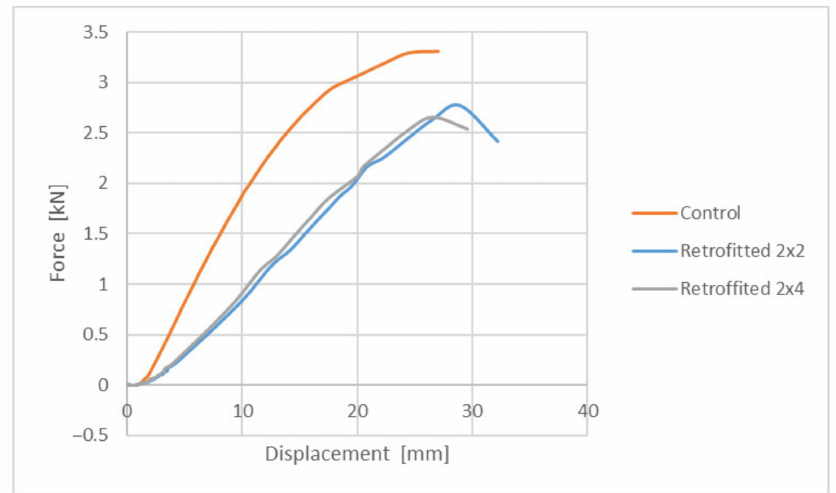
Figure 7. Behavior of samples rehabilitated with “liquid wood” subjected to